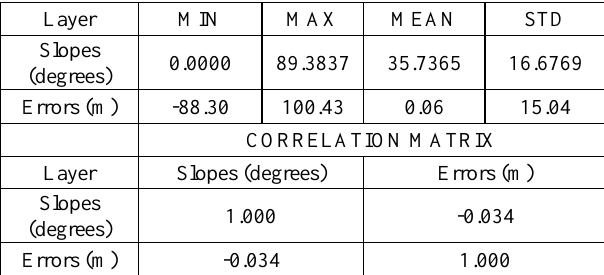
Figure 11. The slope map of the research area (Unit: degrees) Table 2 shows the statistics of the errors of ASTER GDEM and the slopes. The maximum and the minimum slope are 0 and 89.3837 degrees respectively. The mean and the standard deviation of the slopes are 35.7365 and 16.6769 degrees. The correlation coefficient between the errors of ASTER DEM and the slopes is -0.034, which indicates that the accuracy of the ASTER GDEM2 data in the research area is negatively correlated to the slope of the terrain. The errors tend to be large in the flat areas and small in the rough areas. It can be seen from Figure 3 and Figure 11 that most of the flat areas are in the valleys. The large errors at these areas may be caused by worse observation condition. Table 2. Statistics of the slopes and the errors